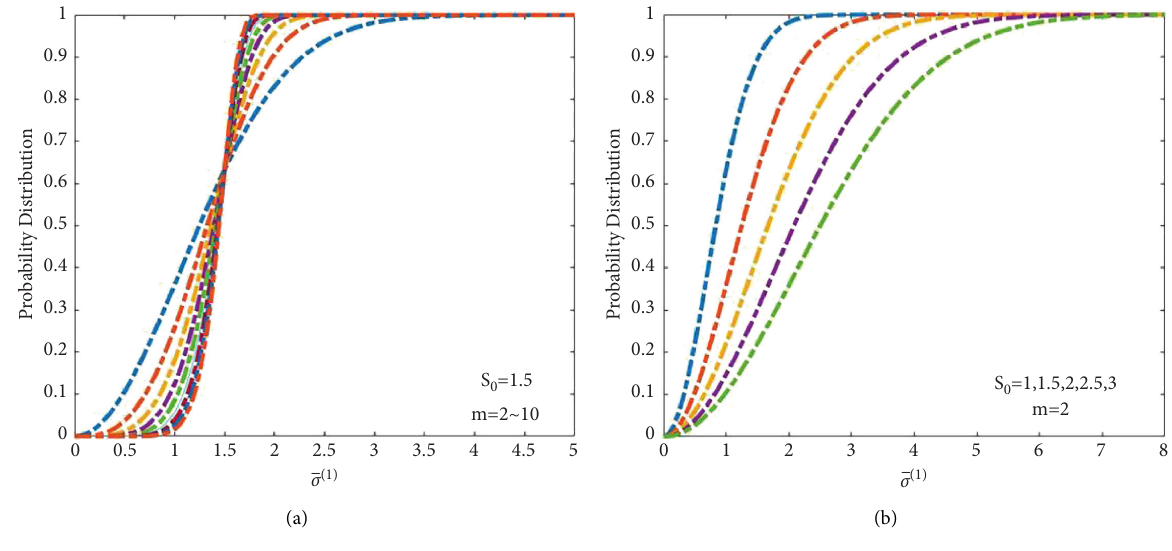
Figure 3: Prediction of detachment possibility with common values.